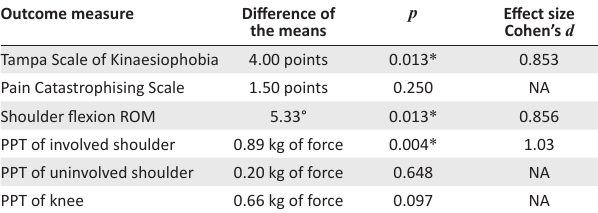
TABLE 1: Outcome measures for Tampa Scale of Kinaesiophobia, Pain Catastrophising Scale, shoulder active ROM and PPT. Outcome